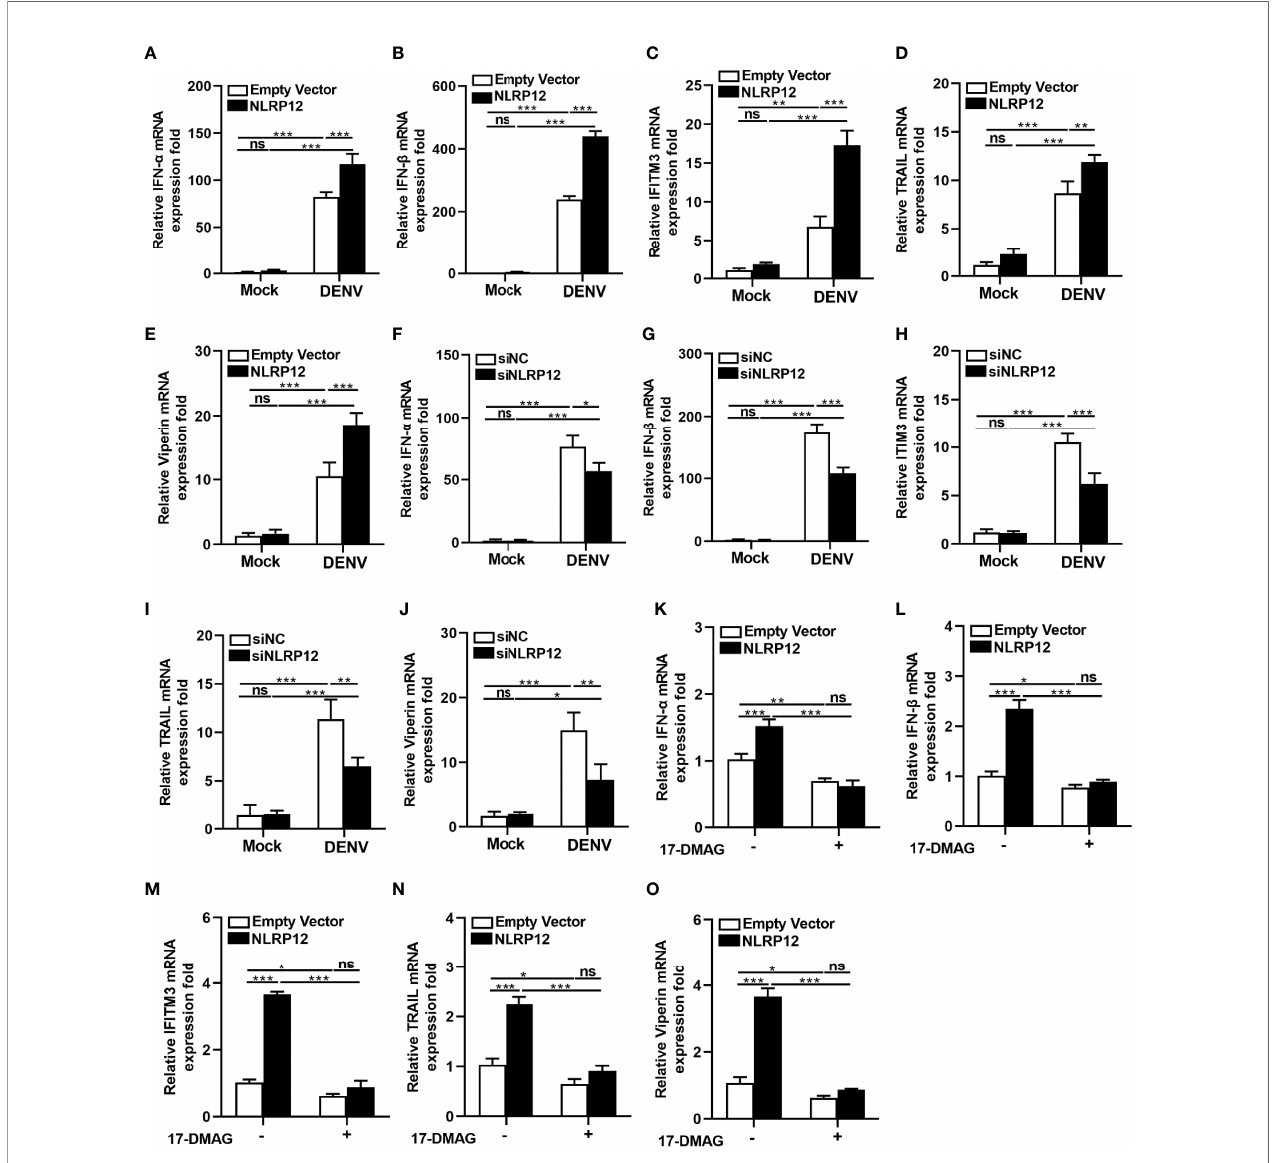
FIGURE 6 | HSP90 and NLRP12 facilitated type I interferon (IFN a / b ) production. dTHP1 cells were transfected with FLAG-tagged NLRP12 plasmid or empty vector plasmid. At 24h post-transfection, cells were infected with or without DENV (MOI: 4) for 72h and the total RNA was isolated and subsequently reverse transcribed. (A, B) The mRNA expression levels of IFNs (IFN- a and IFN- b ) were measured by qPCR. (C – E) The mRNA expression levels of DENV-related ISGs (IFITM3, Viperin or TRAIL) were also measured by qPCR. dTHP1 cells were transfected with control siRNA or NLRP12 siRNA. At 24h post-transfection, cells were infected with or without DENV (MOI: 4) for 72h and the total RNA was isolated and subsequently reverse transcribed. (F, G) The mRNA expression levels of IFNs (IFN- a and IFN- b ) and (H – J) ISGs (IFITM3, Viperin or TRAIL) were measured by qPCR. (K – O) dTHP1 cells were transfected with FLAG-tagged NLRP12 plasmid or empty vector plasmid. At 24h post-transfection, cells were treated with 1 m M 17-DMAG for 24h and infected with or without DENV. Then the total RNA was extracted and reversely transcribed. The mRNA expression levels of NLRP12, IFNs (IFN- a and IFN- b ) and ISGs (IFITM3, TRAIL and Viperin) were measured by quantitative real-time PCR. Each experiment was repeated a minimum of three times and the statistical signi fi cance was determined with analysis of one-way analysis of variance (ANOVA). ns, non signi fi cant, *p < 0.05, **p < 0.01, ***p <